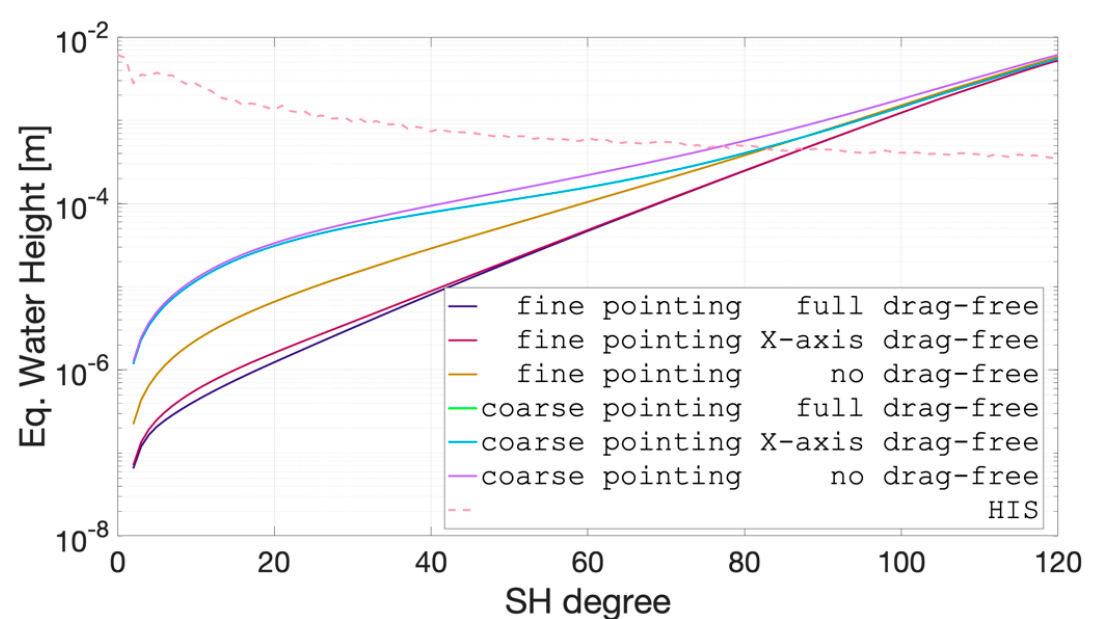
Figure 21. Degree RMS of the error in the gravity field coefficients in terms of EWH resulting from the laser interferometer, the accelerometer, and associated drag-free and pointing regimes. The curves for X-axis and full drag-free for the coarse pointing (green and light blue lines) are overlapping. Table 5. Maximum spatial resolution of the different scenarios to fully observe the HIS signal, in spherical harmonic degree (SHD) and